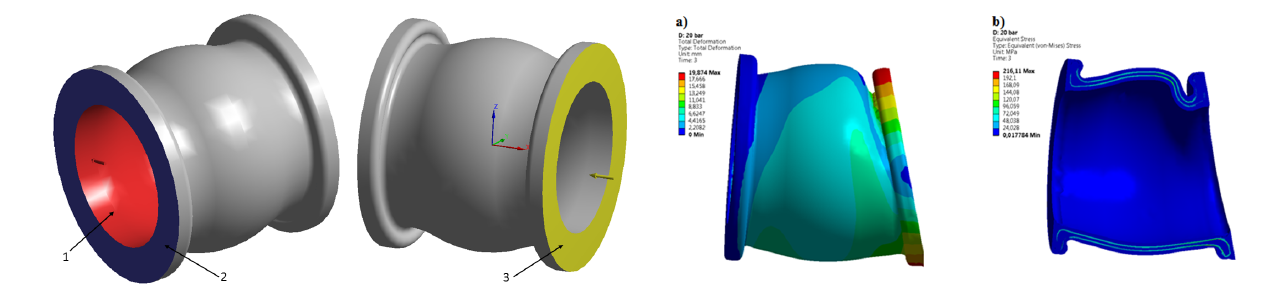
Figure 12: Boundary condition of the elastic diaphragm: 1 –the sur- face where the internal pressure was applied; 2 – the plane where fixed support was applied; 3 – the plane where displacements were applied.